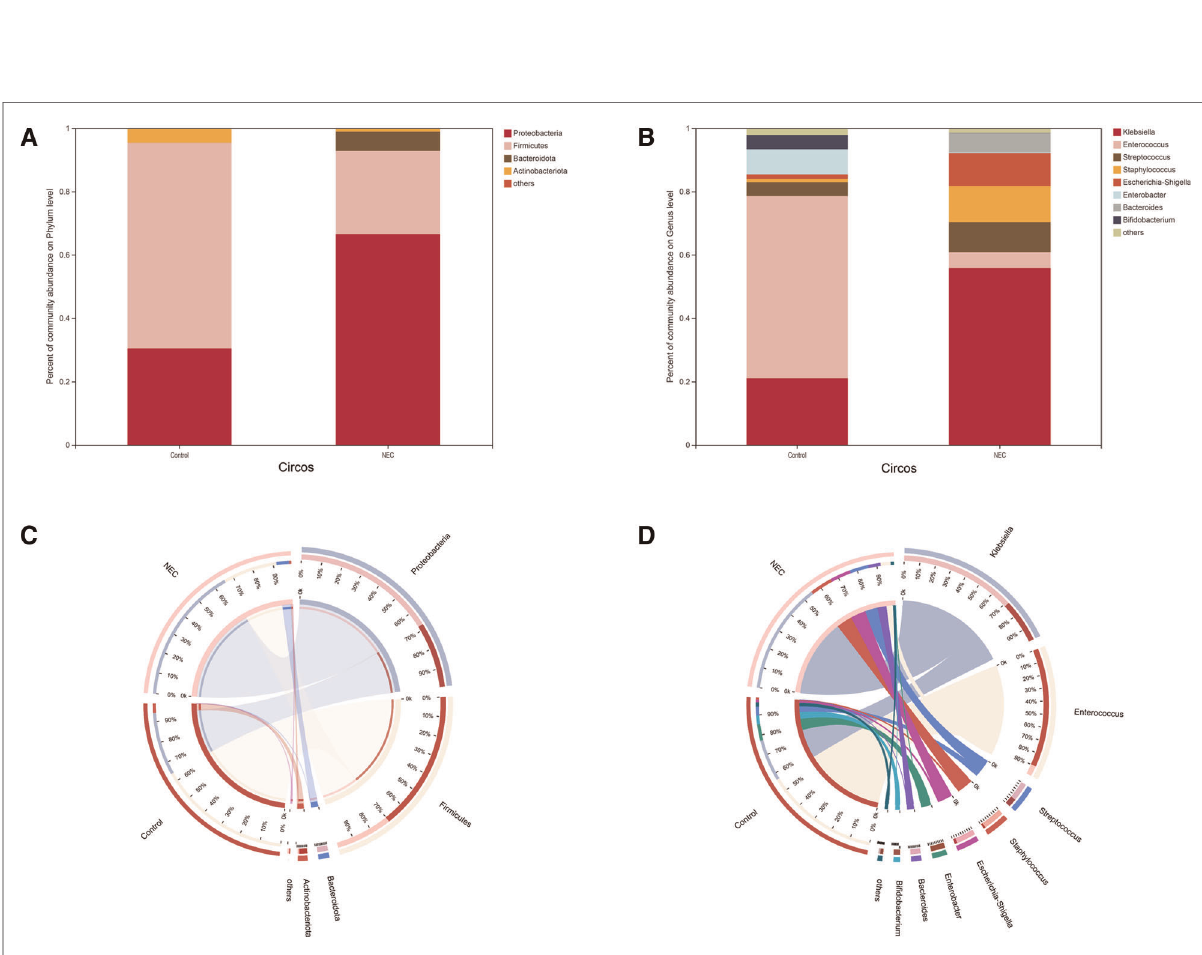
FIGURE 3 Community composition analysis showing the species composition of each group of samples: ( A ) phylum level, ( B ) genus level; composition and distribution of dominant species in the sample: ( C ) circos diagram of phylum level, ( D ) circos diagram of genus level.The abundance levels of certain bacteria are associated with NEC